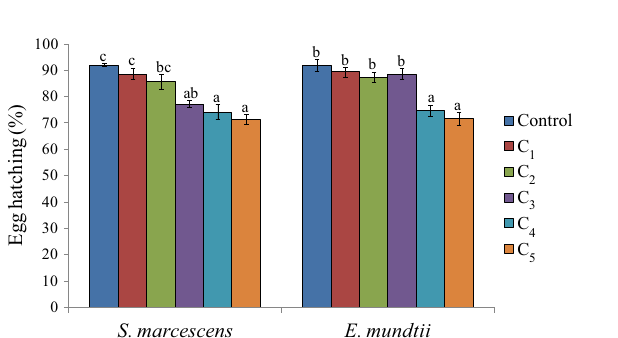
Figure 8. Influence of different concentrations of S. marcescens (C 1 = 2.6 × 10 8 cfu/ml, C 2 = 6.4 × 10 8 cfu/ml, C 3 = 1.6 × 10 9 cfu/ml, C 4 = 3.0 × 10 9 cfu/ml and C 5 = 5.2 × 10 9 cfu/ml) and E. mundtii (C 1 = 4.6 × 10 8 cfu/ml, C 2 = 8.9 × 10 8 cfu/ml, C 3 = 1.8 × 10 9 cfu/ml, C 4 = 3.4 × 10 9 cfu/ml and C 5 = 6.1 × 10 9 cfu/ml) on egg hatching of S. litura . Columns and bars represent the mean ± SE. Different letters above the columns represent significant differences at Tukey’s test p ≤